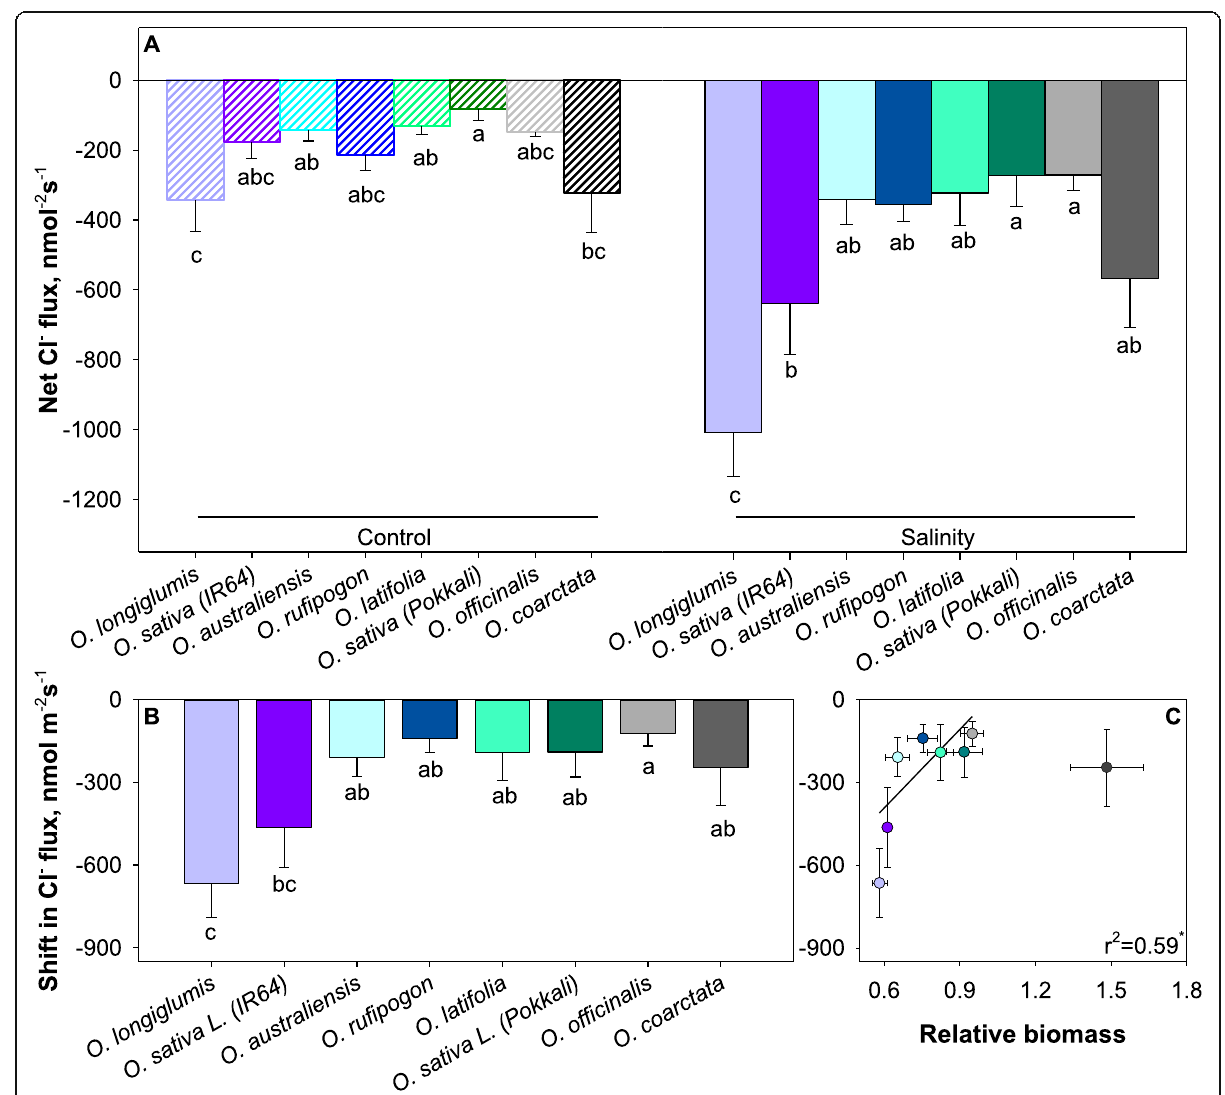
Fig. 4 Linking salinity tolerance of wild and cultivated rice to net Cl − ion fluxes of mesophyll cells. Salinity treatment was applied at 100 mM NaCl for 42 days. ( A ) Shift in Cl − flux was the flux difference between flux from salinity stressed and control samples. ( B ) Pearson analysis of shift in Na + flux with relative biomass. ( C ) Data are means and the error bars indicate the standard errors. Different lowercase letters indicate significant differences at P < 0.05 for each Duncan